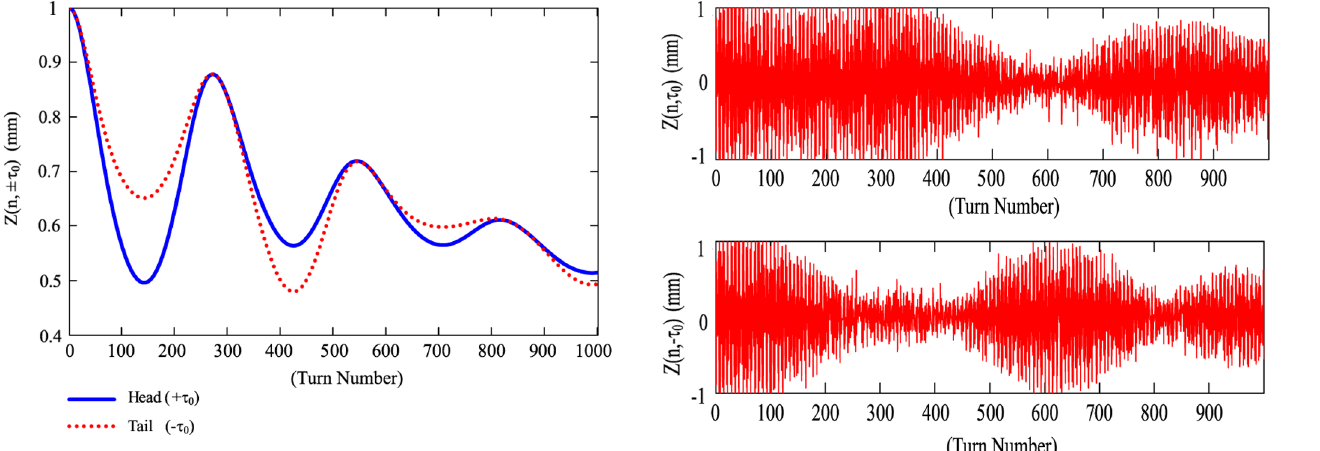
FIG. 7. (Color) Plot of Z (cid:3) n; (cid:1) (cid:4) measured versus n turns. Shown (cid:5) 2 : 7 (cid:10) 10 11 . Transverse is a high intensity bunch with N (cid:5) 4 nsecs ) p 0 beam motion after 1 mm kick with 0.4 nsec longitudinal bunch (cid:5) slices of head (top) and the tail (bottom) each 4 nsecs ( (cid:1) 0 4 nsecs ) from the bucket center. Chromaticity is measured to be (cid:5) 3 nsecs (cid:4) (cid:5) 4 : 0 (cid:9) 1 and (cid:8) (cid:1)